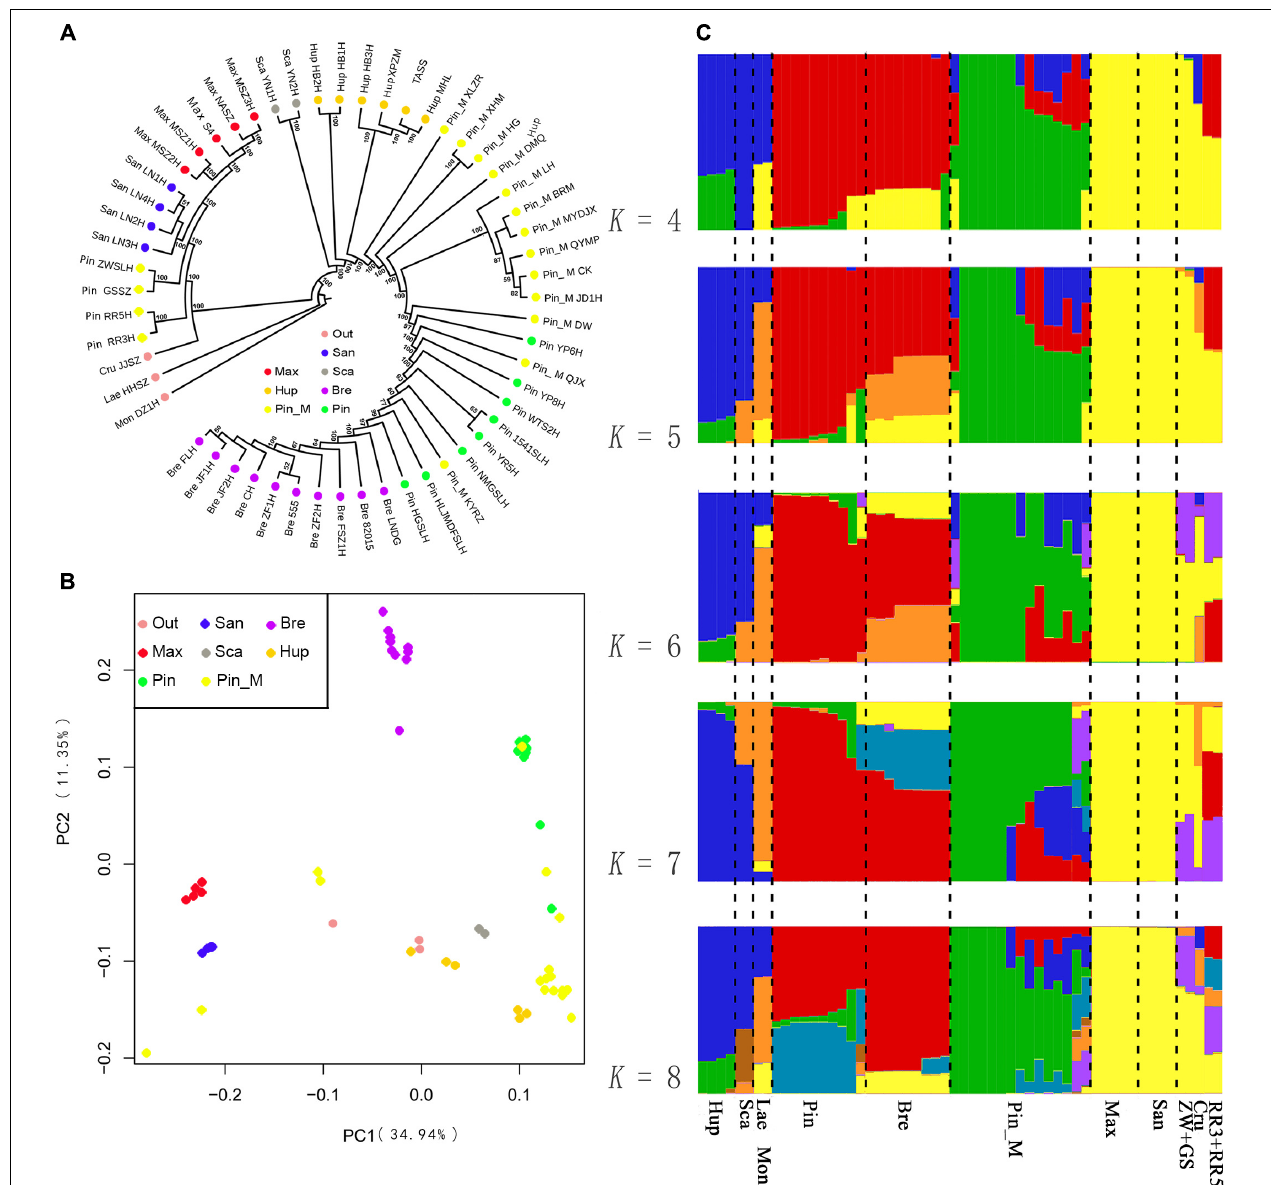
FIGURE 2 | Population structure of 56 samples. (A) ML phylogenetic tree constructed using SNPs. Each species group is color coded. (B) Principal component analysis ( PCA ) of the 56 samples. (C) Bayesian model-based clustering of 56 samples with the number of ancestry kinship ( K ) from 4 to 8. Each vertical bar represents one hawthorn sample. Each color represents one putative ancestral